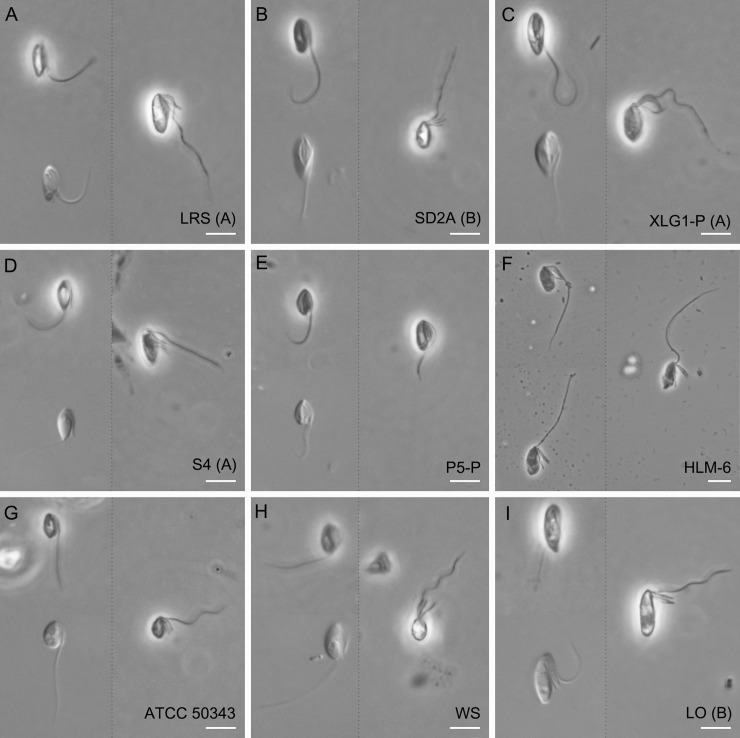
General light micrographs of Percolomonas cosmopolitus-like strains (ordered by source salinity as in Table 1).(A) New strain LRS. (B) New strain SD2A. (C) New strain XLG1-P. (D) New strain S4. (E) New strain P5-P. (F) Strain HLM-6 (the type for Percolomonas lacustris as described by A.P. Mylnikov [38]). (G) “Percolomonas cosmopolitus” ATCC 50343. (H) “Percolomonas cosmopolitus” strain WS, originally reported by Nikolaev et al. [28]. (I) New strain LO. Note that the right cell image in each panel represents a fixed cell. Groups (A) and (B) indicate halophile clades ‘A’ and ‘B’ in Fig 3. All scale bars represent 5 μm.